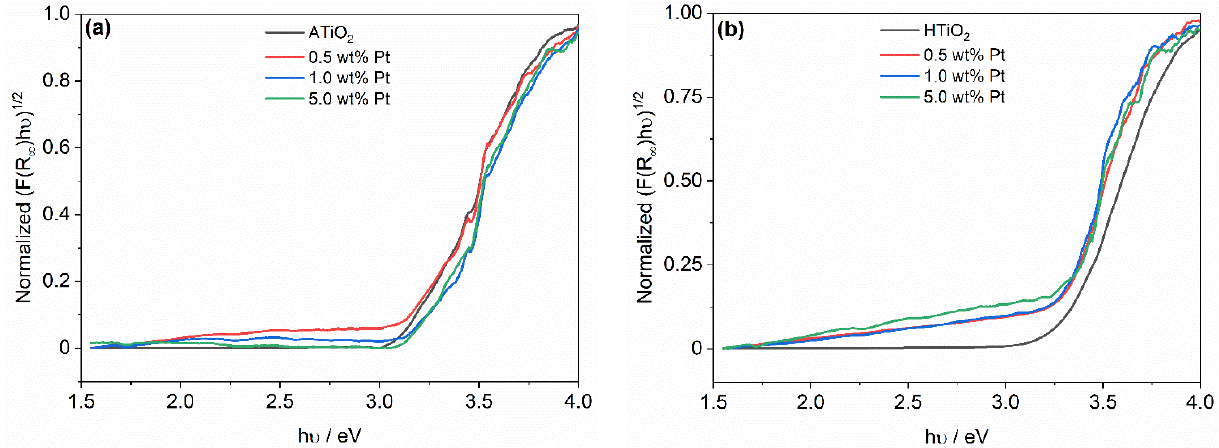
Figure 2. Normalized diffuse reflectance spectra (Tauc plot vs. photon energy) of pristine and platinized samples for ( a ) ATiO 2 and ( b ) HTiO 2 .